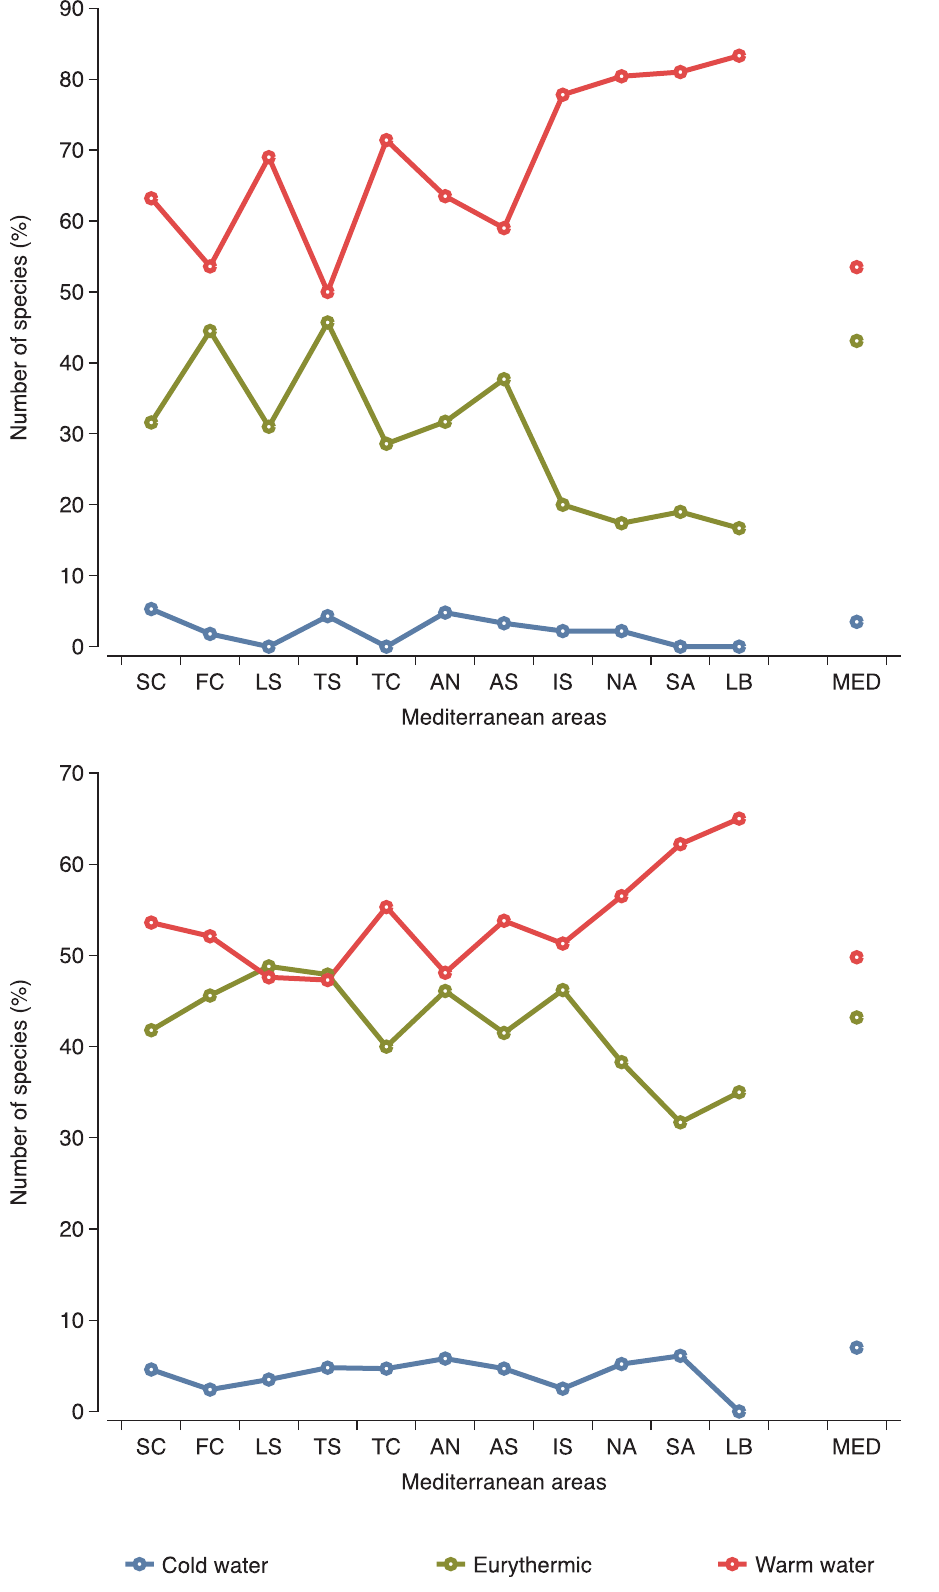
Figure 10. Bioclimatic categories of sponge species in Mediterranean subareas and throughout the Mediterranean. (A) cave fauna, (B) overall Mediterranean fauna. For abbreviations of Mediterranean areas see Methods.